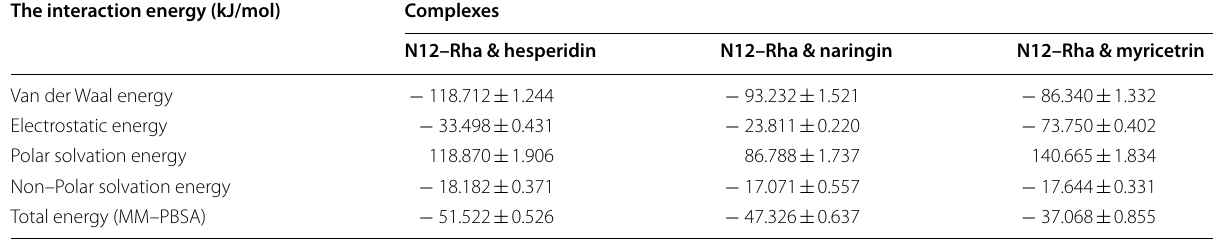
Table 3 Interaction energy of the N12-Rha with hesperidin, naringin and myricetrin based on MM-PBSA analysis, respectively The interaction energy (kJ/mol)